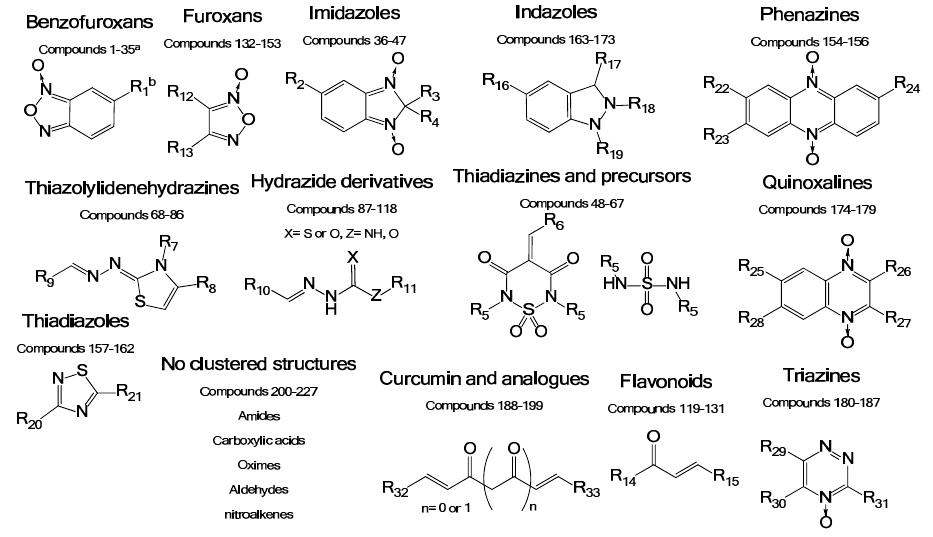
Figure 2. General structures of the different chemotypes studied as R. microplus TIM ( Rm TIM)